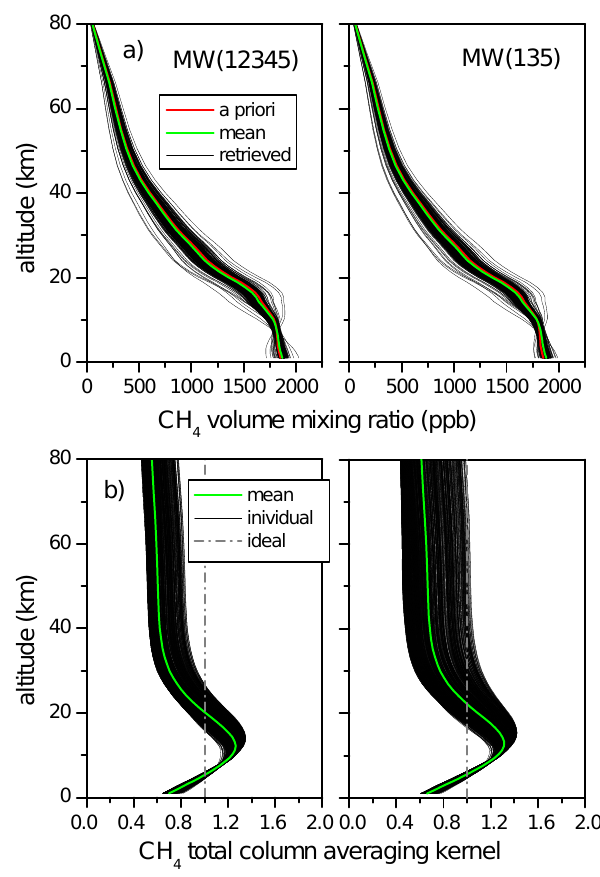
Fig. A1. (a) Ensembles of retrieved methane profiles using two dif- fering micro window sets, i.e. MW (12345) and MW (135); HI- TRAN 2000 has been used in both cases. (b) Corresponding total- column averaging